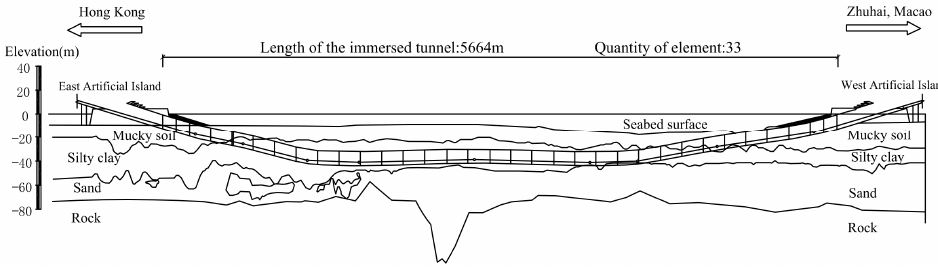
Figure 1. Longitudinal layout of the HZMB immersed tunnel.